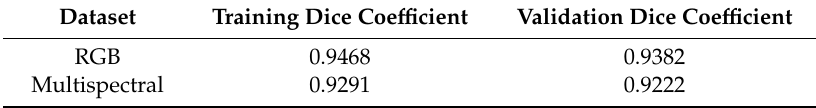
Figure 6. Loss and dice curves of the Red, Green, NIR (RGN) image dataset model. Table 2. Dice coe ffi cient of the training dataset and validation dataset.